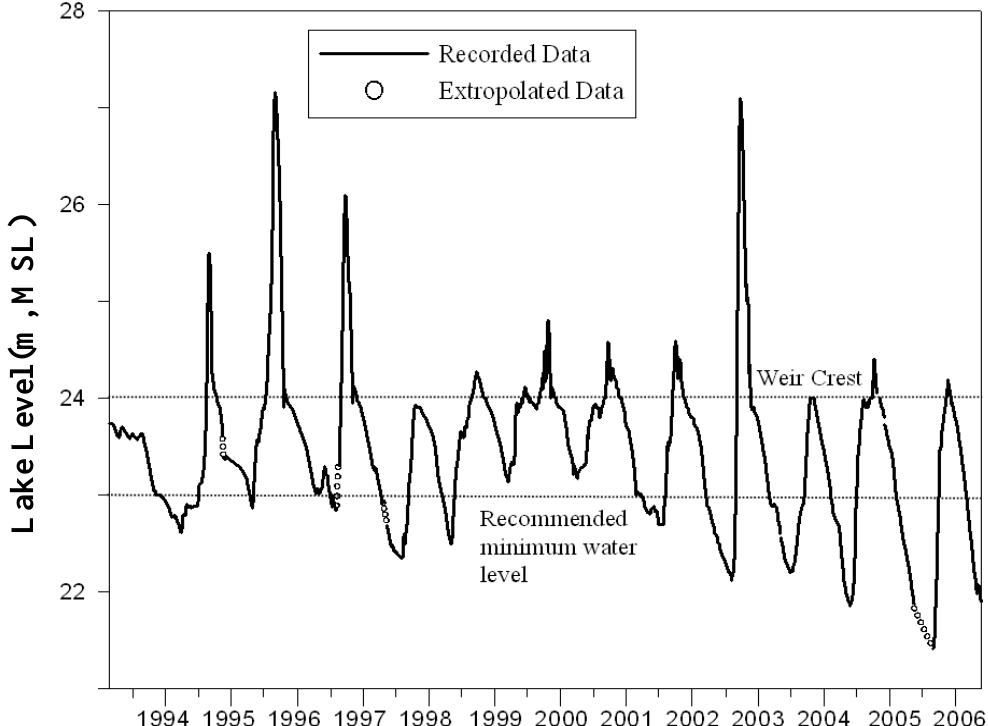
Figure 5. Daily observations of water level of Bung Boraphet